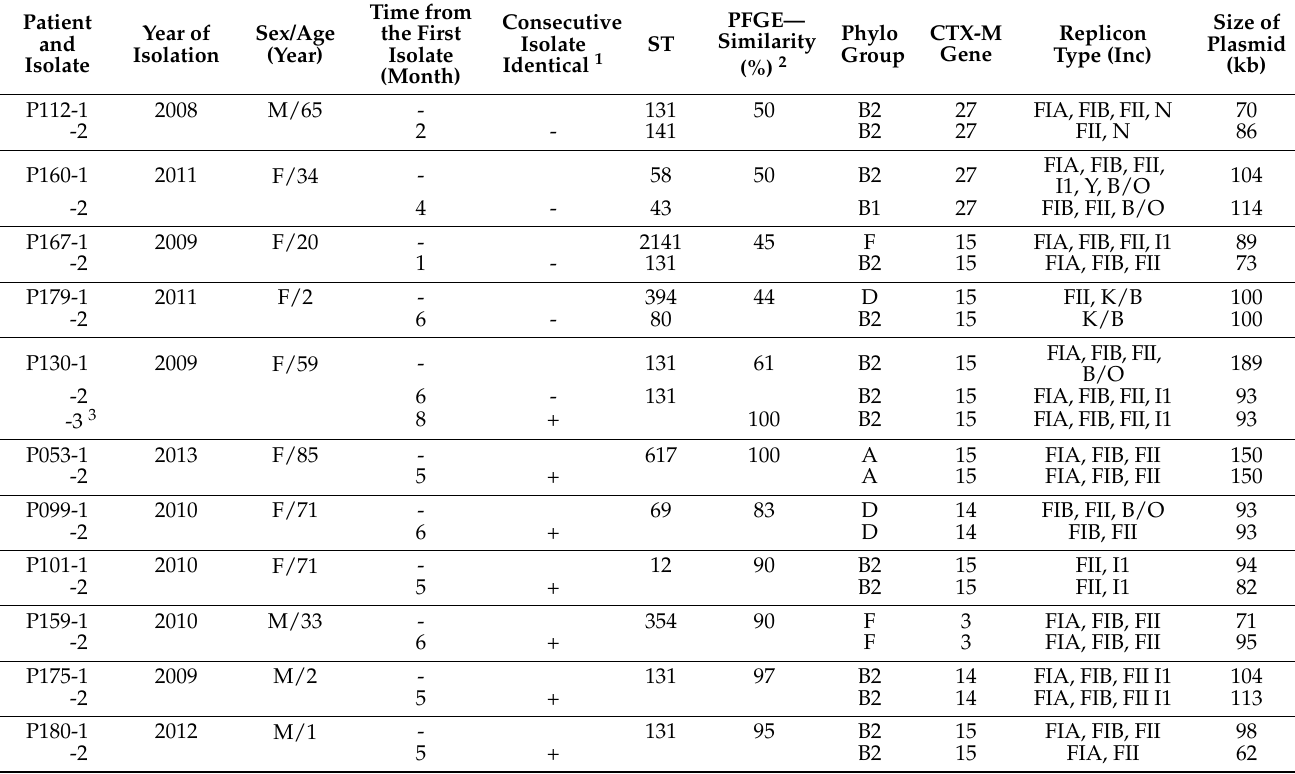
Table 1. Detailed characteristics of 23 ESBL E. coli isolates analyzed for bla CTX-M plasmid identity from 11 patients with recurrent urinary tract infection caused by the same or different ESBL E. coli strains in the consecutive UTI episodes. Patient